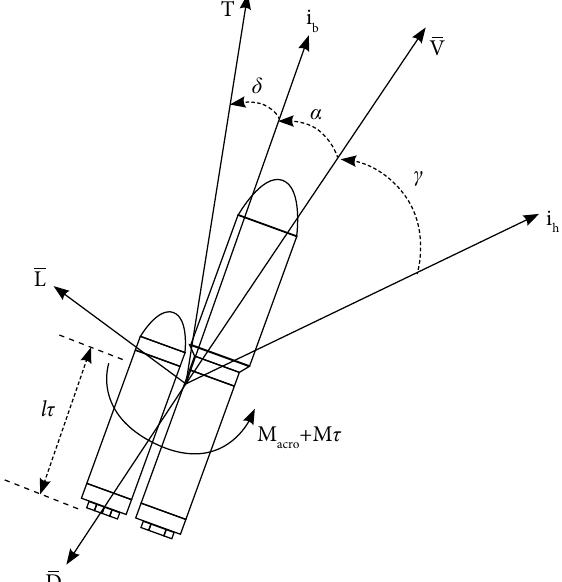
Figure 2. launch vehicle force’s and moment’s nomenclature [Hesami Rostami and Tolouie, 2015]